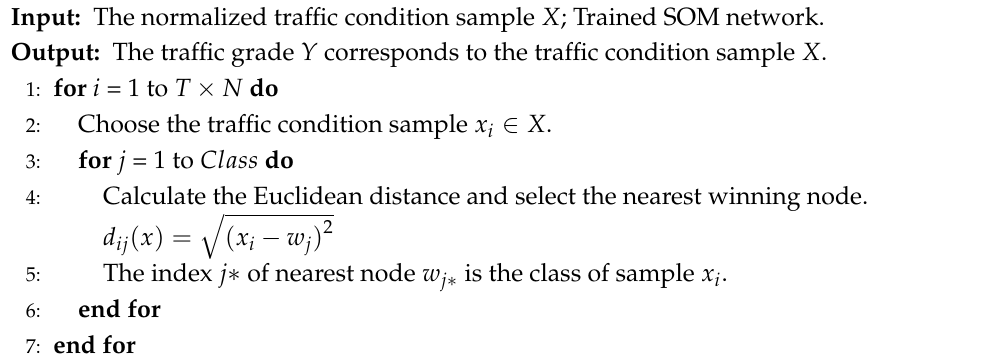
Algorithm 2 Testing process of self-organizing mapping neural network (SOM)